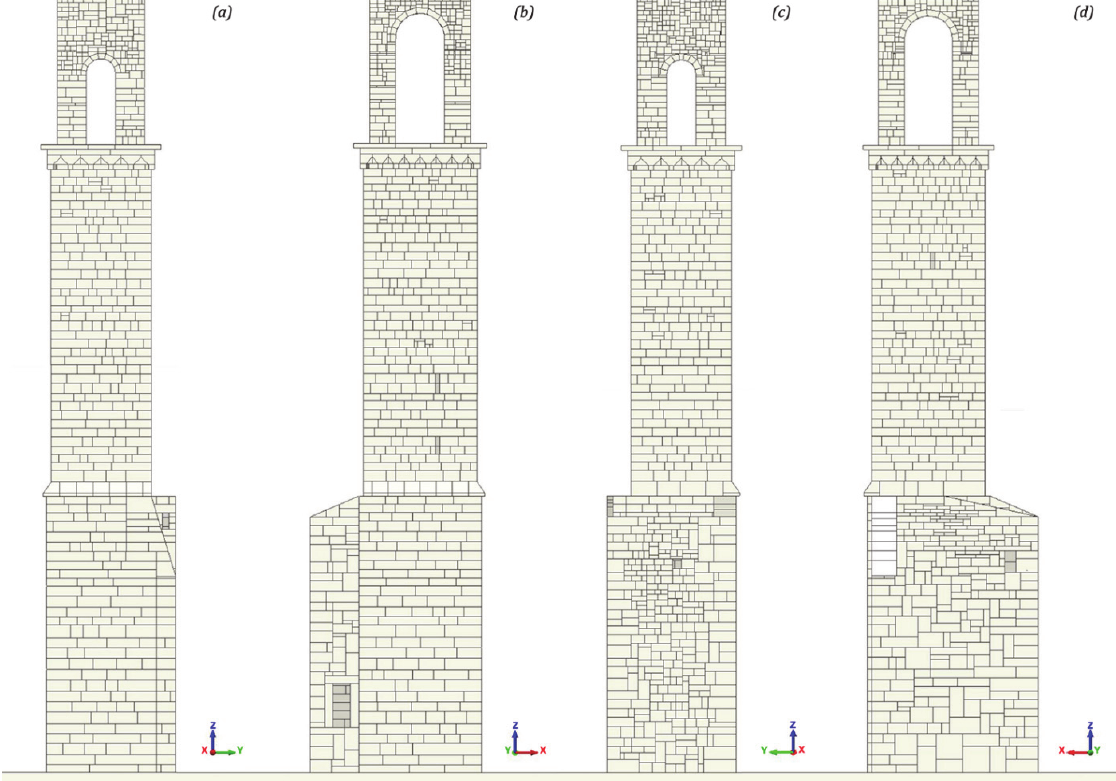
Figure 10: Views of the North façade (a), East façade (b), South façade (c), West façade (d) of the numerical model without steel chains of the civic clock tower of Amatrice (Rieti, Italy) with the NSCD